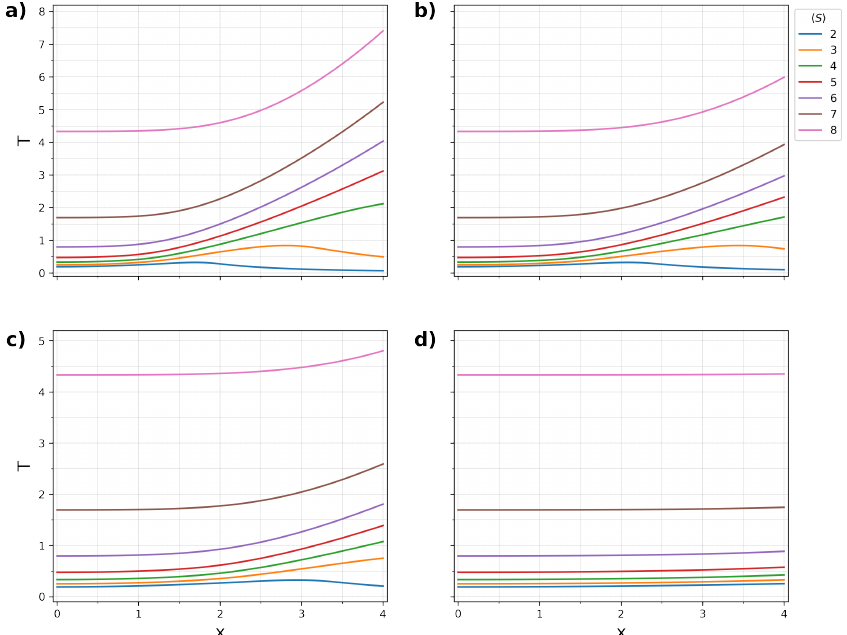
Figure 4. This figure shows the behavior of the temperature, as a function of the dimensionless parameter x , at constant values of the entropy. The entropy S takes the values 2 to 8, in steps of one, in increasing order from the down curve to the up curve. As in the previous figures, ( a – d ) stand for values of the asymmetry parameter α = 1, 1.5, 0.5, and 0.1, respectively.